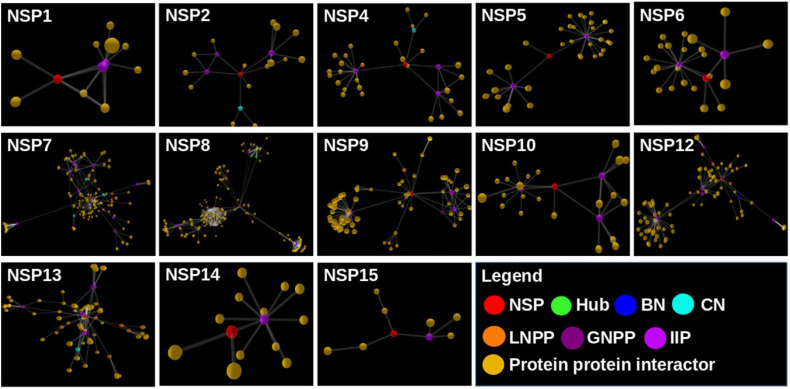
Network view of the interactome of non-structural proteins (NSPs) with their human interactor proteins and their first layer of interactors. Different topologically important nodes (TINs) are marked in different colors. Red, NSPs; yellow, protein–protein interactors; green, hubs; blue, bottlenecks; cyan, central proteins; orange, local network perturbing protein (LNPP); purple, global network perturbing proteins (GNPPs); magenta, important interacting proteins (IIPs).